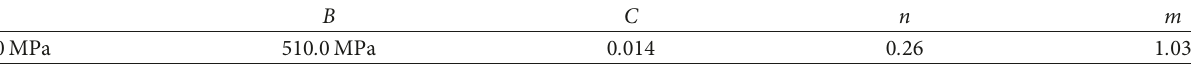
Table 6: The relevant parameters for material strength